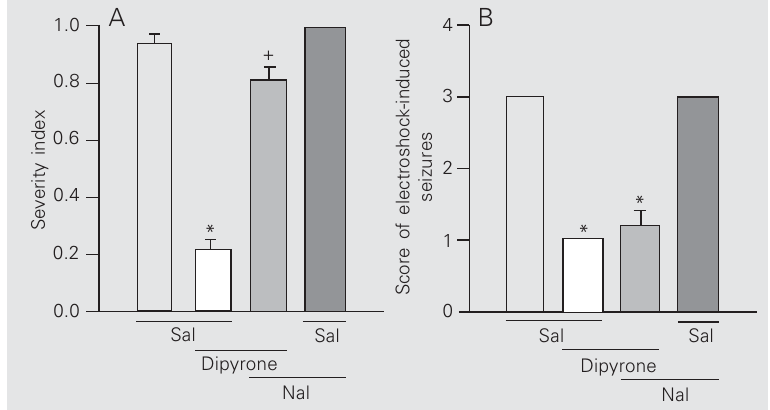
Figure 1. Anticonvulsant effect of dipyrone on audiogenic sei- zures (AS, panel A) and elec- troshock-induced seizures (ES, panel B). Dipyrone (Dip; 300 mg/ kg, ip ) blocked the tonic compo- nent of seizures in both AS and ES. Dipyrone was administered 30 min before the seizure-induc- ing stimuli in female Wistar au- diogenic rats in AS or female Wistar rats in ES. Data are reported as mean ± SEM severity index or mean ES score (N = 5-